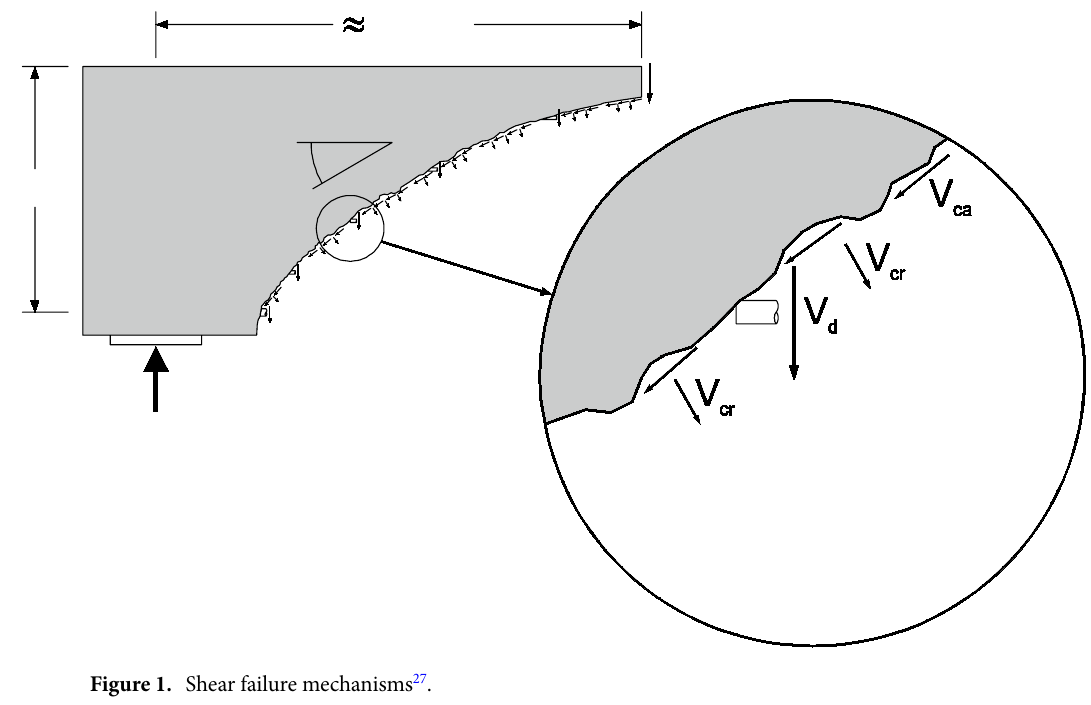
Figure 1. Shear failure mechanisms 27